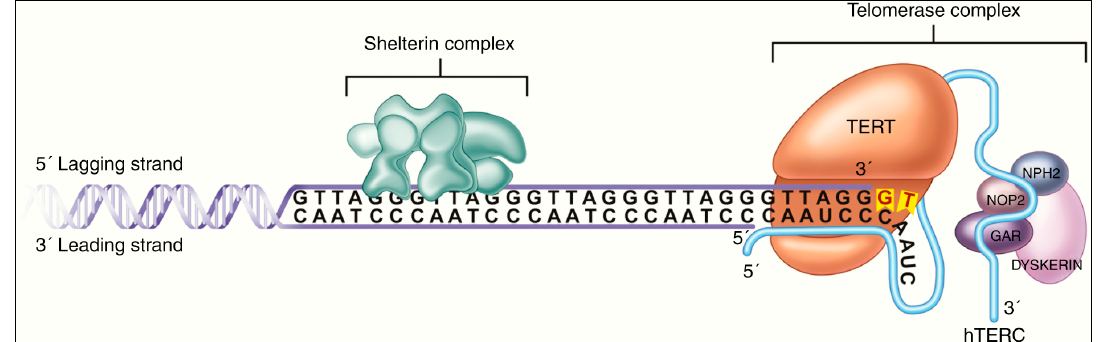
Figure 4. Mechanism of action of TERT enzyme, whose regulation is impacted by methylation of promoter and upstream THOR sequence. In the figure, TERT accesses the telomere complex at the terminal end of the DNA strand, through the Shelterin complex. It then catalyzes the addition of telomere repeat segments with the help of the hTERC enzyme, in a structure called Telomerase Complex. The latter’s function of telomere elongation works against the routine telomere shortening that occurs during DNA replication. Figure reproduced under Creative Commons Attribution-Non- commercial 4.0 License from [74].